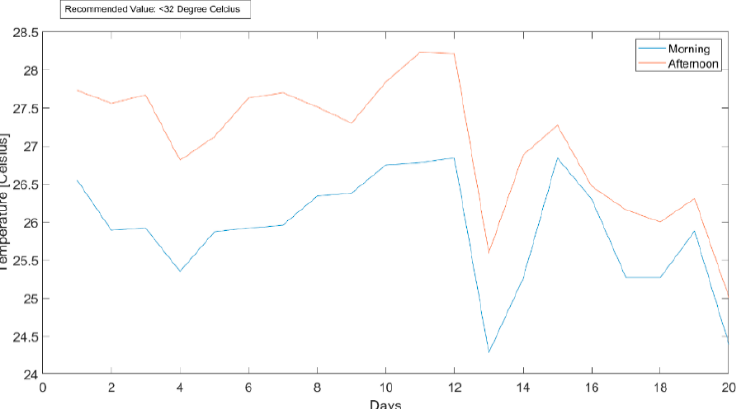
Table 5. Summary of parameters.